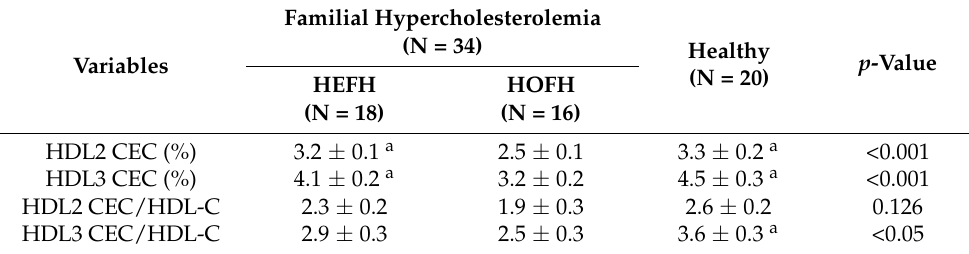
Table 3. CEC% of HDL from FH patients and healthy controls.